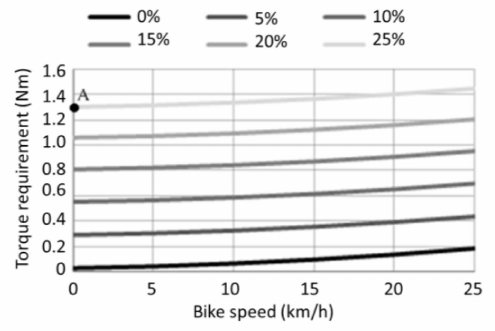
Figure 2. The torque required at various bike speeds and road